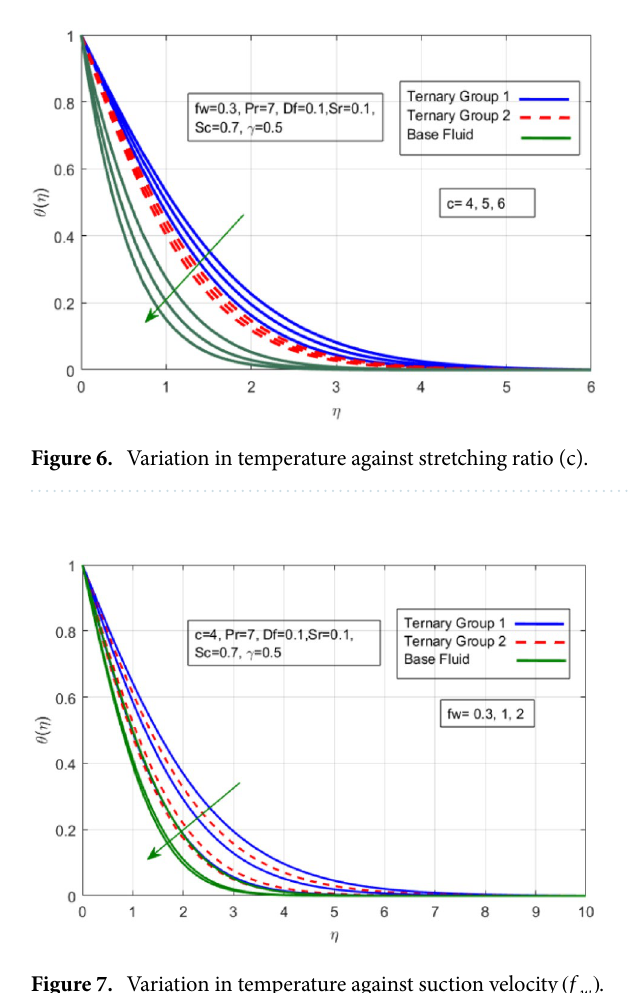
Figure 7. Variation in temperature against suction velocity ( f w ) .